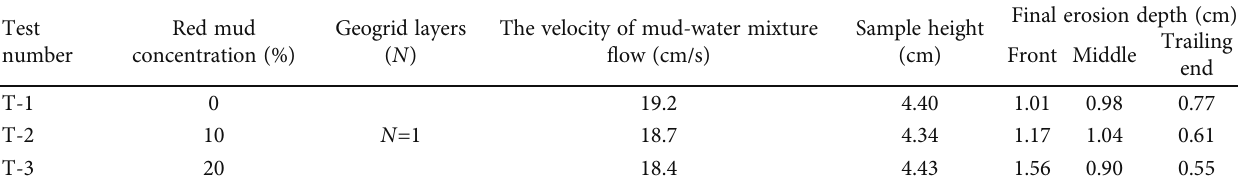
Figure 9: The layout of reinforcement-a layer of geogrid-at regional scale. Table 3: Experimental conditions and testing